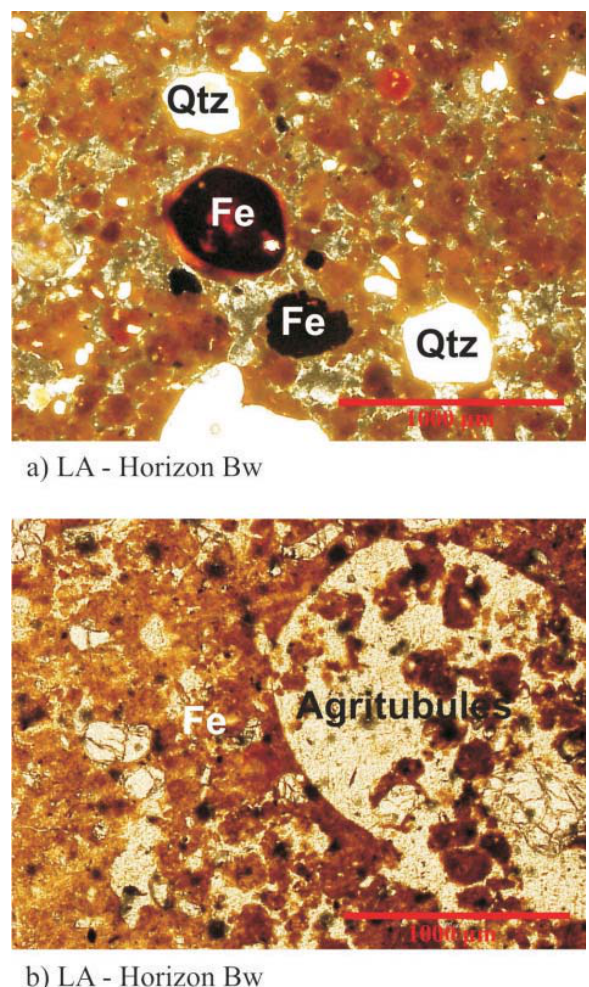
Figure 7. Photomicrographs of the Bw horizon of the LA: (a) quartz and iron nodules, predominantly stacking porosity throughout the photo- micrograph, taken under polarized light; (b) agrotubules filled with clay and iron oxides, taken under ambient light.